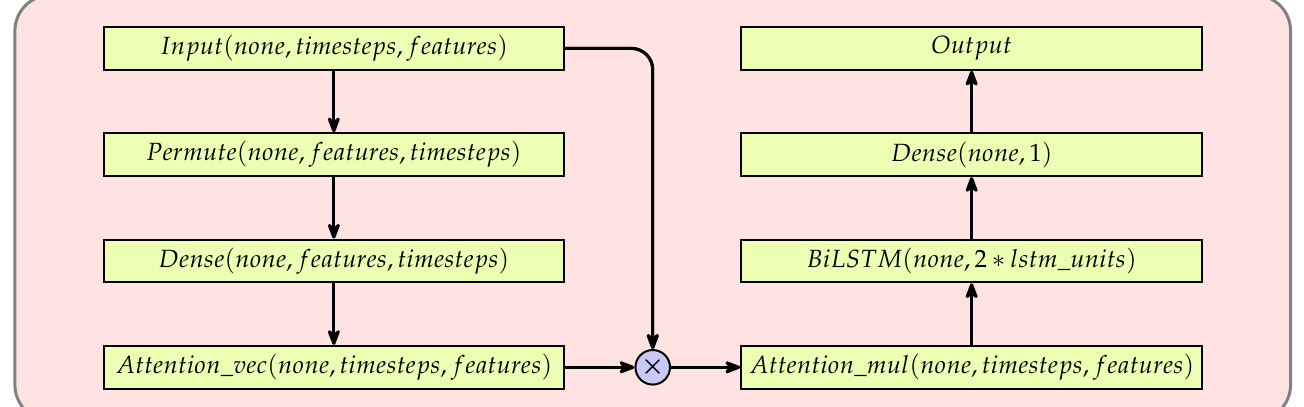
Figure 1. The framework of the method proposed in this